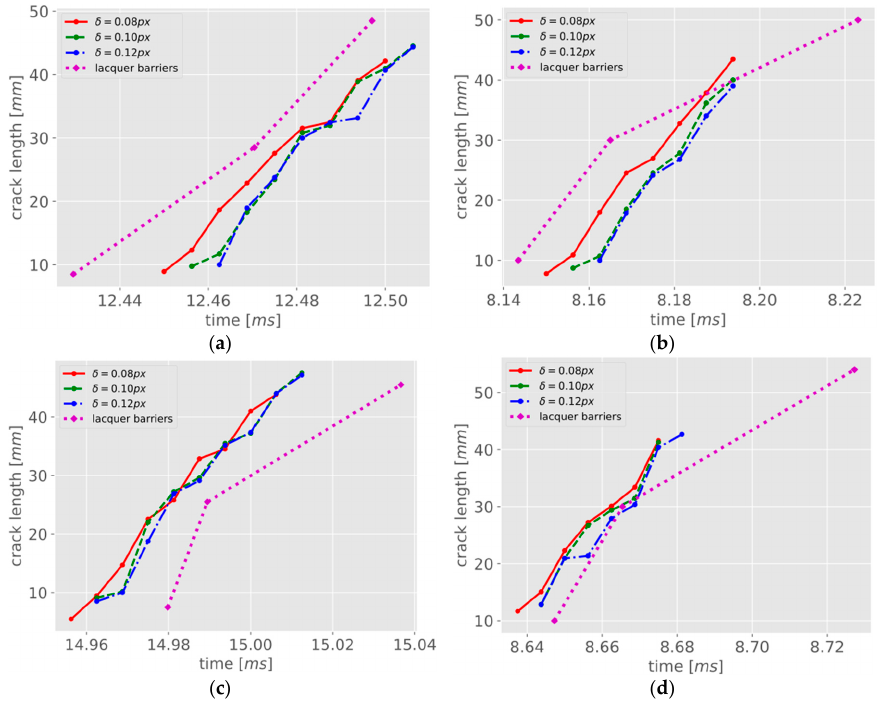
Figure 13. Crack length over time plots using the photogrammetric method with different thresholds